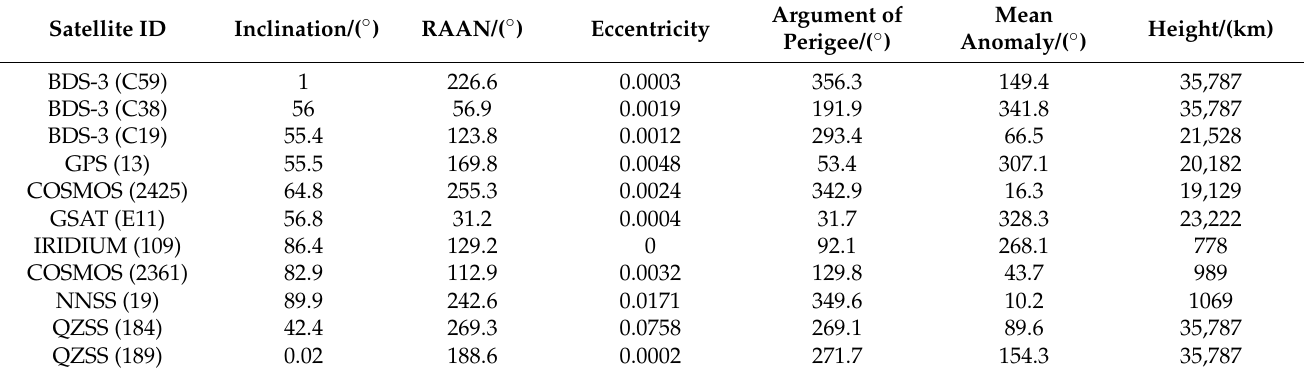
Table 1. Main orbital elements of representative transmitting satellites from their TLE data files.